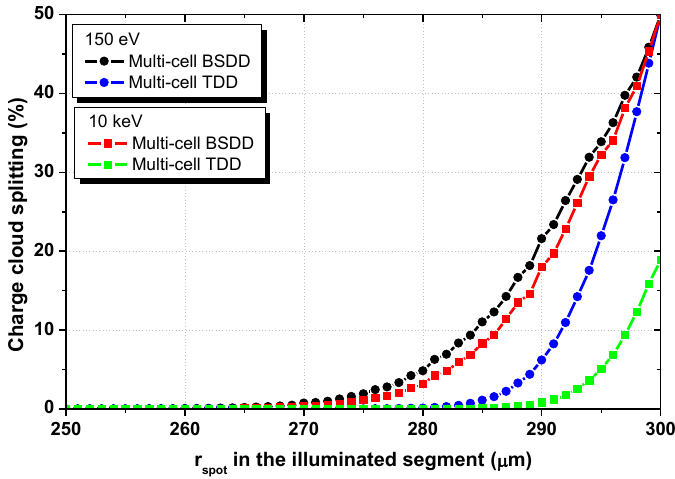
Figure 14. Charge cloud splitting to the non-illuminated cell versus the position of the impinging light spot in the adjacent illuminated cell, for a light spot width of 0.1 µm and a light energy of 150 eV or 10 keV.